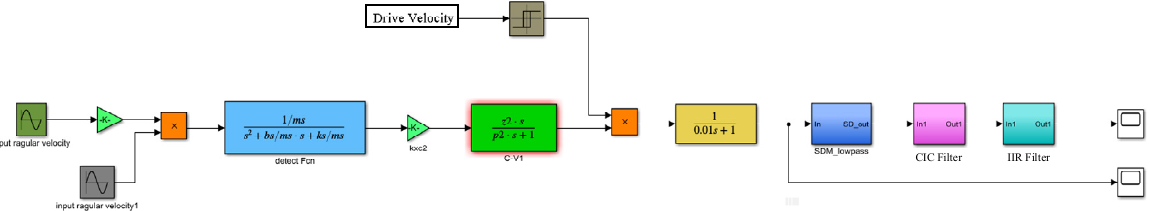
Figure 8. System-level model of gyroscope sense circuit.